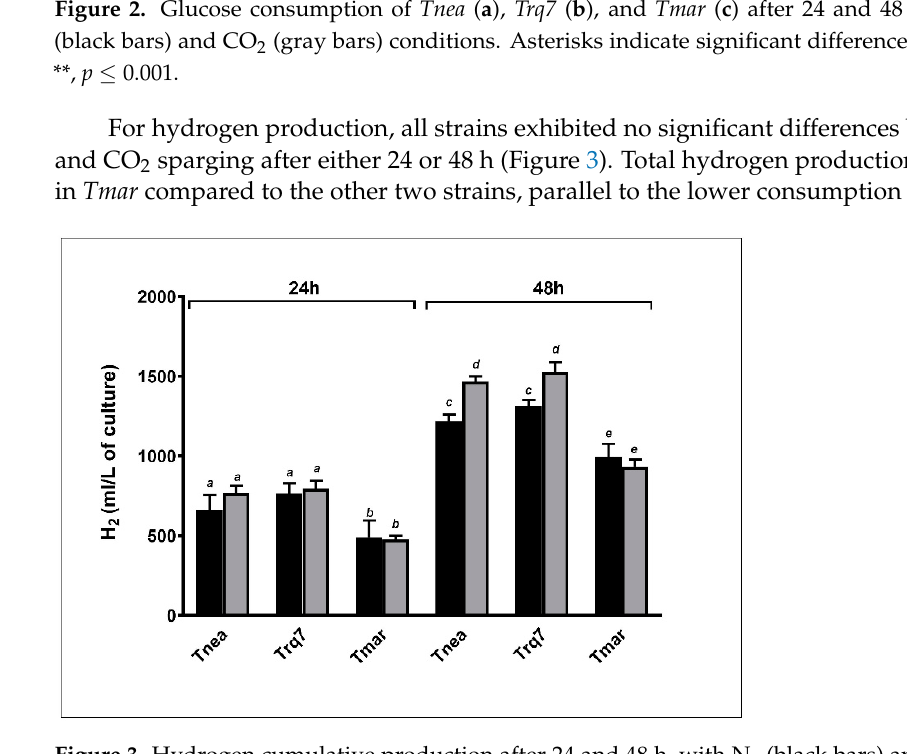
Figure 3. Hydrogen cumulative production after 24 and 48 h, with N 2 (black bars) and CO 2 (gray bars). Letters indicate ANOVA significance between treatments and species.